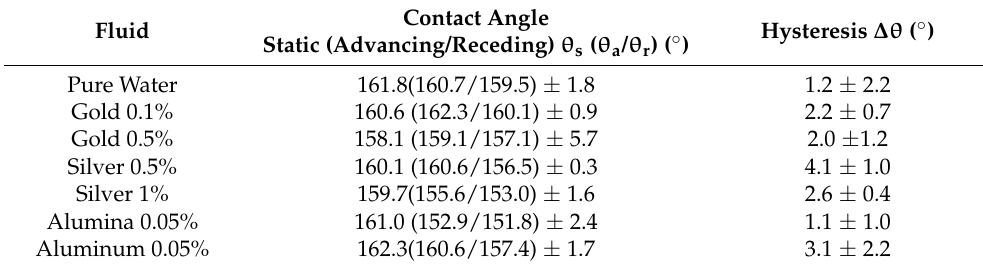
Table 2. Mean contact angle results for the superhydrophobic spot for pure water and different nanofluids, at a temperature of 20 ◦